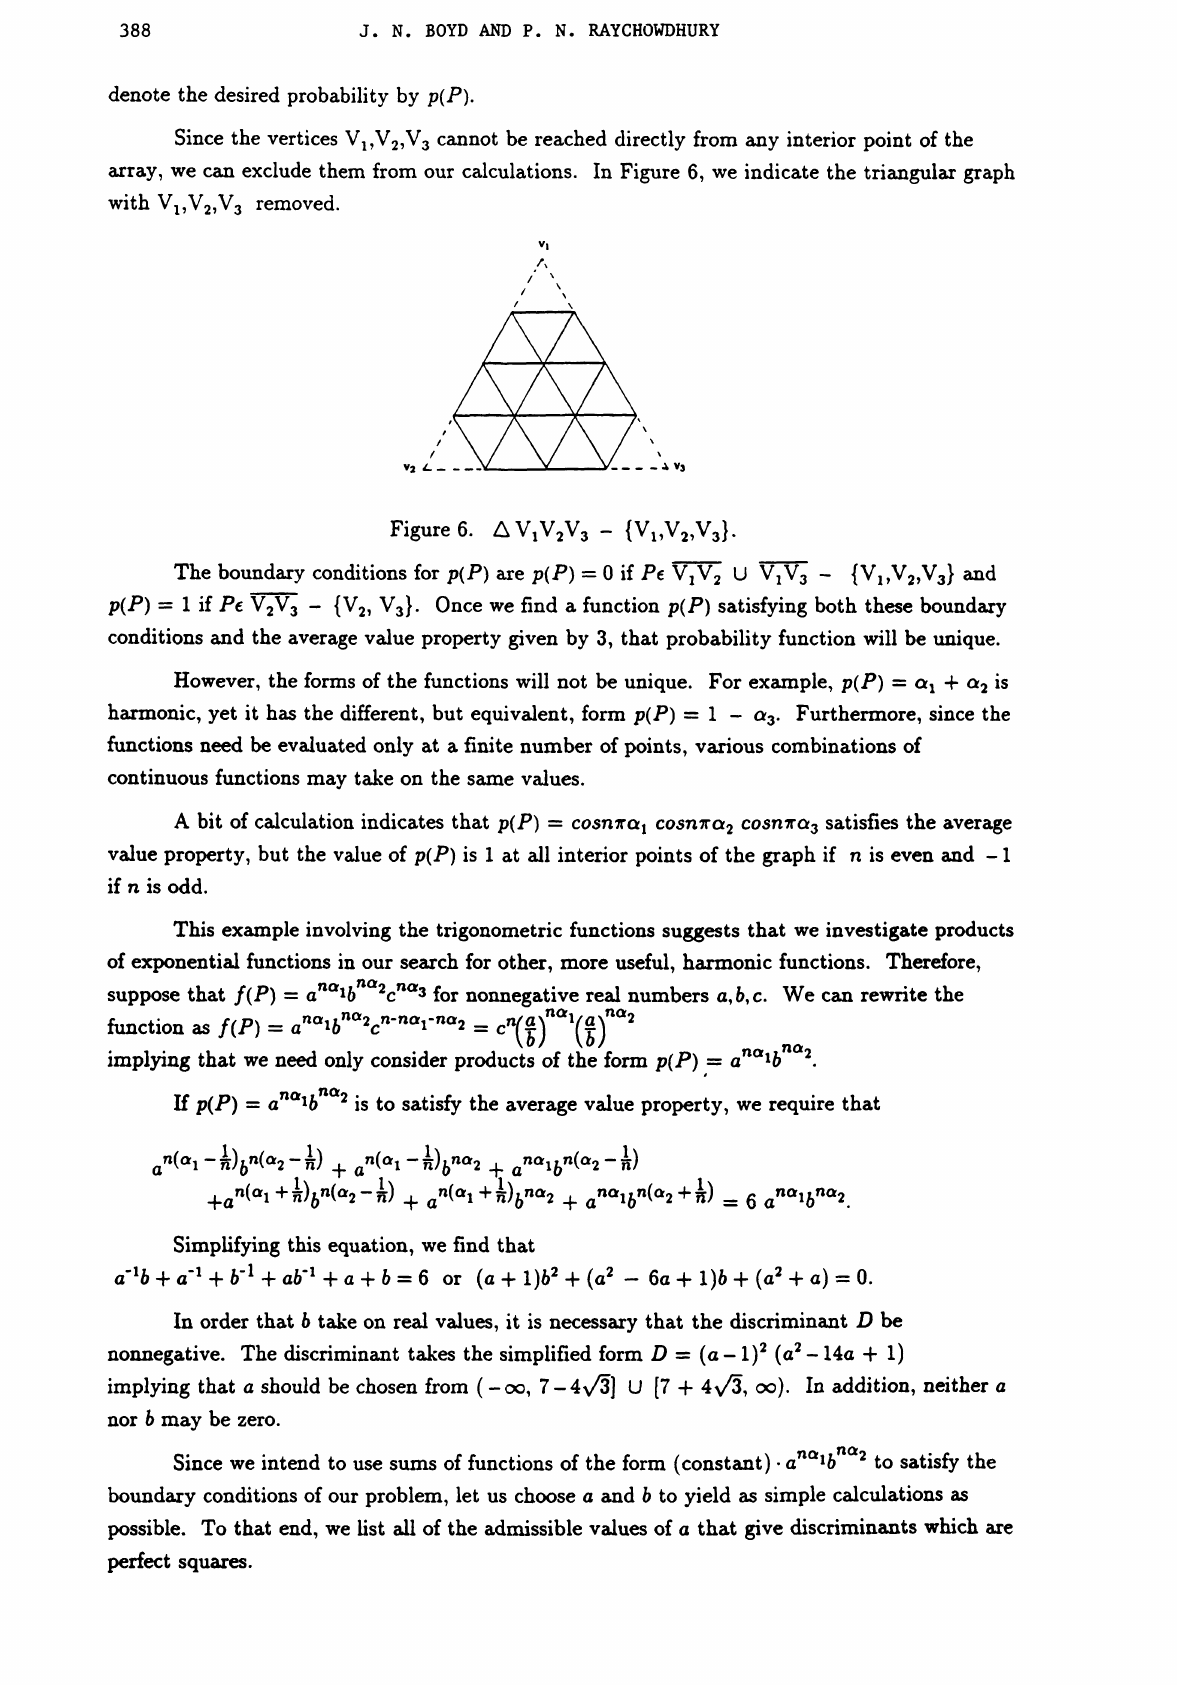
Figure 6. AV1V2V